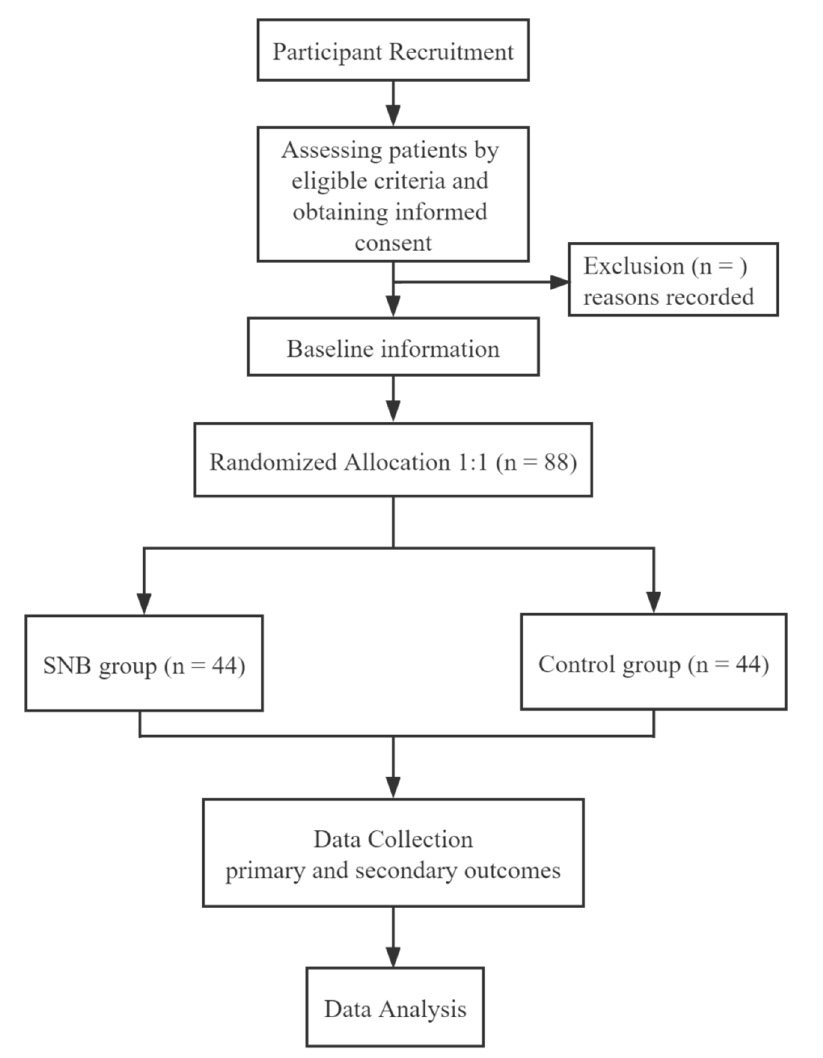
Figure 1. Flow chart of participants in the trial. Table 1. The schedule of enrollment, interventions, and assessments for the trial.